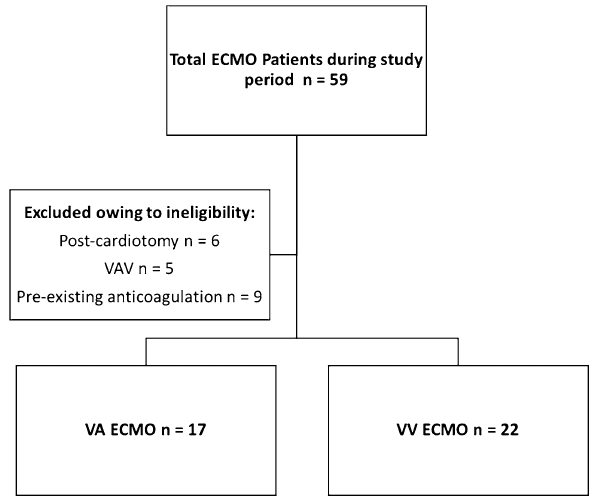
Figure 1. Total ECMO patients within study period and included